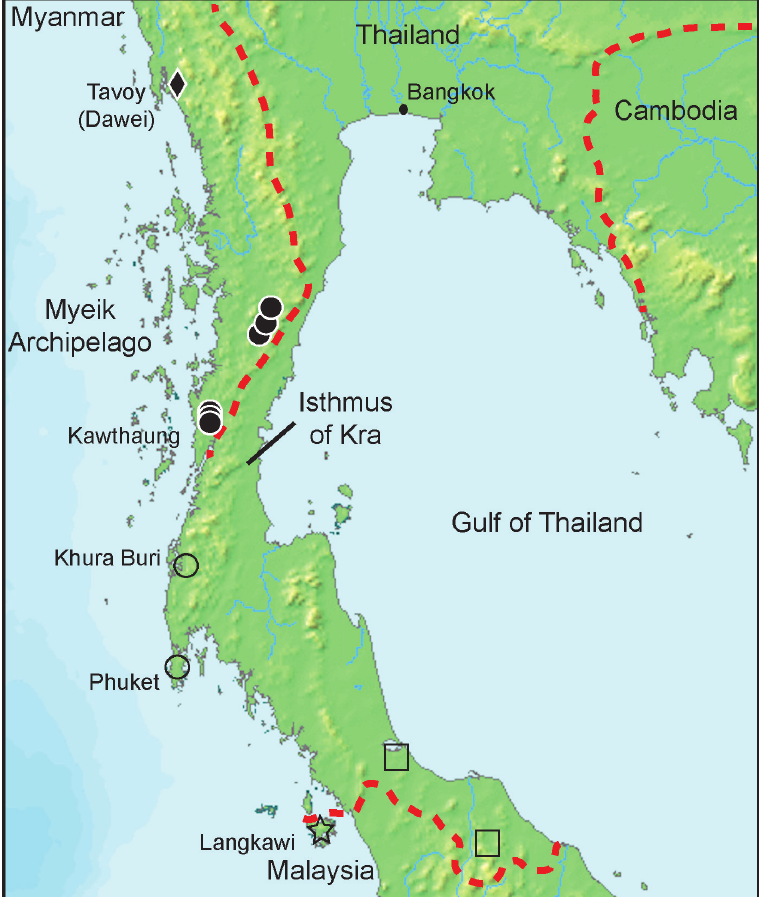
Figure 1. Distribution of Bronchocela burmana (solid circles) in southern peninsular Myanmar, Taylor’s (1963) two localities for B. cristatella (open squares) in southern Thailand, and B. rayaensis type locality (star) in northwestern Peninsular Malaysia and its newly reported localities (open circles) in Thailand (Grismer et al. 2016). A solid diamond denotes the type locality of B. burmana . The red dashed lines depict the political boundaries between Myanmar-Thailand, Cambodia-Thailand, and